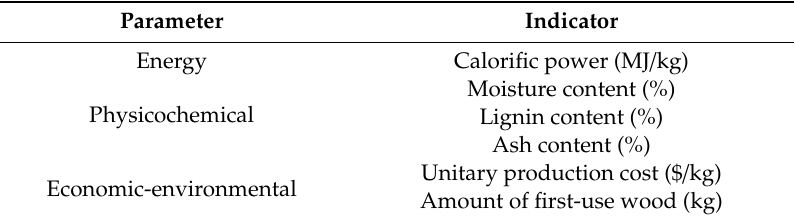
Table 7. Parameters and indicators utilized in the multi-criteria analysis.